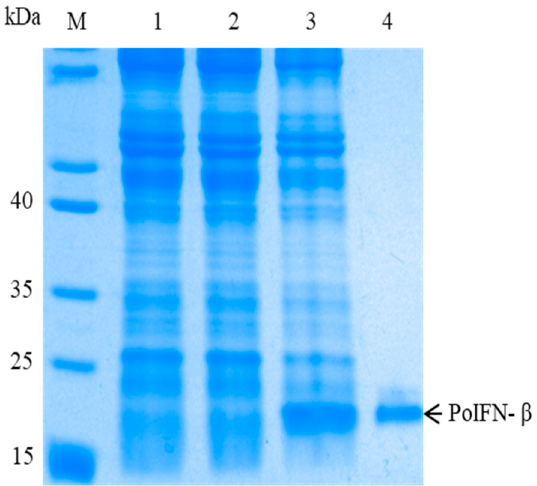
Figure 4. Expression and purification of rPoIFN ‐β from Bama miniature pig. The protein samples were run on 12% SDS ‐ PAGE. 1–4 indicate pET ‐ 30a ‐ tansformed E. coli , pET30a ‐ PoIFN ‐β transformed E. coli before IPTG induction, pET30a ‐ PoIFN ‐β transformed E. coli after IPTG induction and purified rPoIFN ‐β , respectively.